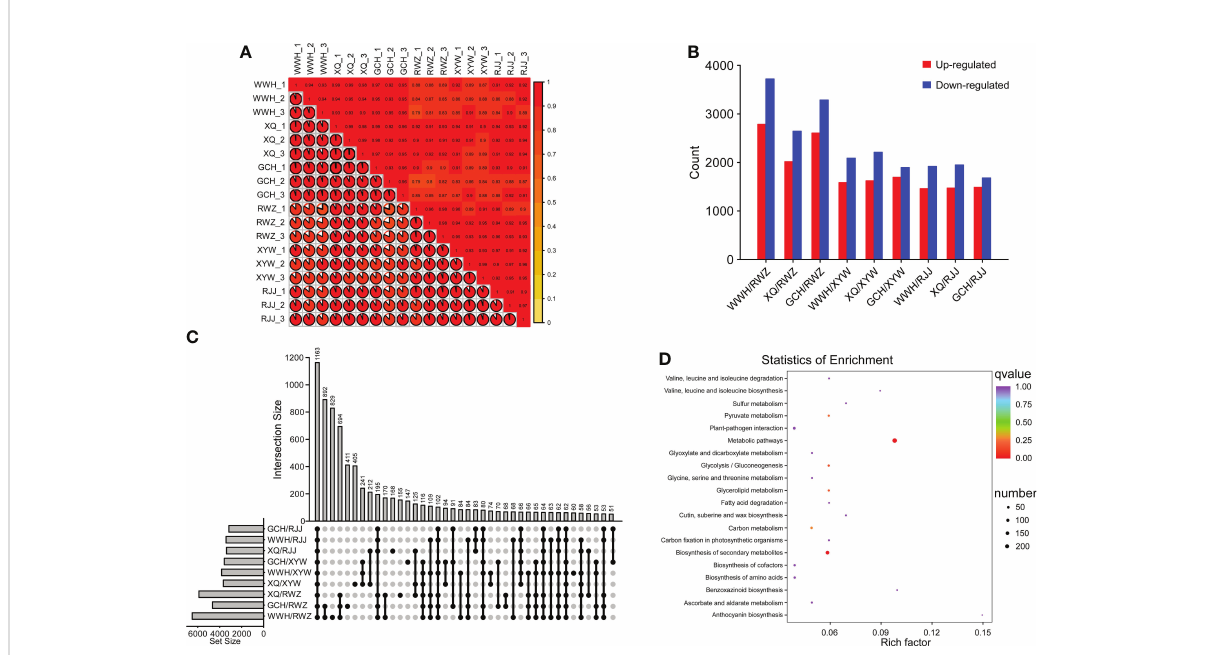
FIGURE 2 Preliminary analysis of transcriptome data. (A) heat map of correlation in different comparison groups. (B) The number of DEGs in each group. (C) The number of common DEGs in white and yellow inner-leaf Chinese cabbage (|log2Fold Change| ≥ 1, FDR< 0.05). (D) KEGG enrichment analysis of DEGs between the comparison groups (Yellow vs White inner-leaf Chinese cabbage). Each bubble in the plot represents a metabolic pathway. A larger bubble size indicates a larger impact factor. Darker bubble colors represent a higher degree of